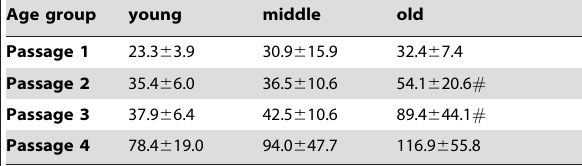
Table 1. Generation time of MSC of the three donor age groups at passage 1–4 with results show mean values 6 standard